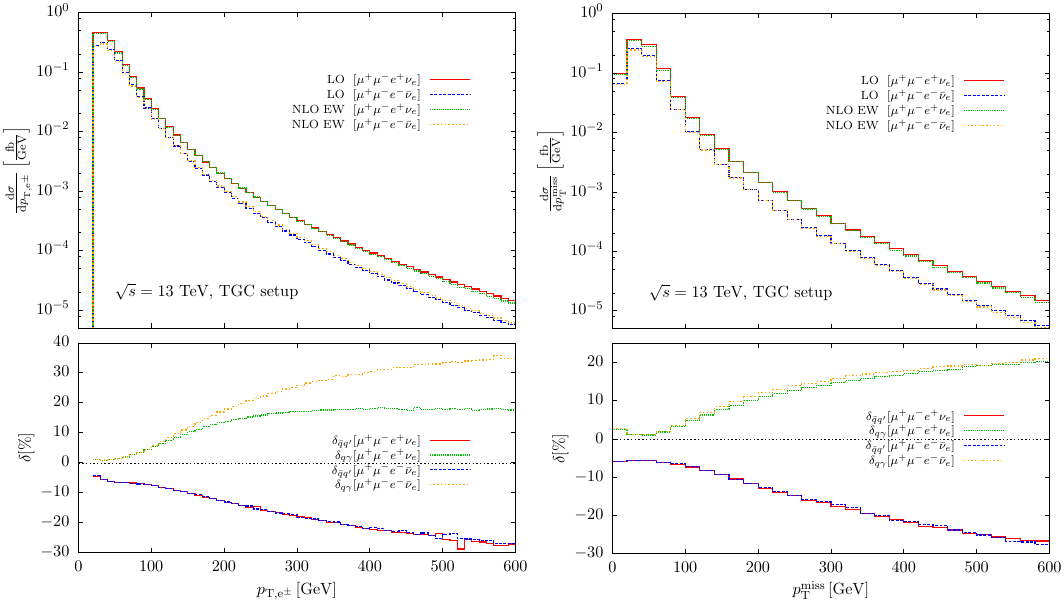
Figure 6 . Distribution in the transverse-momentum of the charged W-decay lepton (left panel) and the missing-transverse momentum (right panel) in the TGC